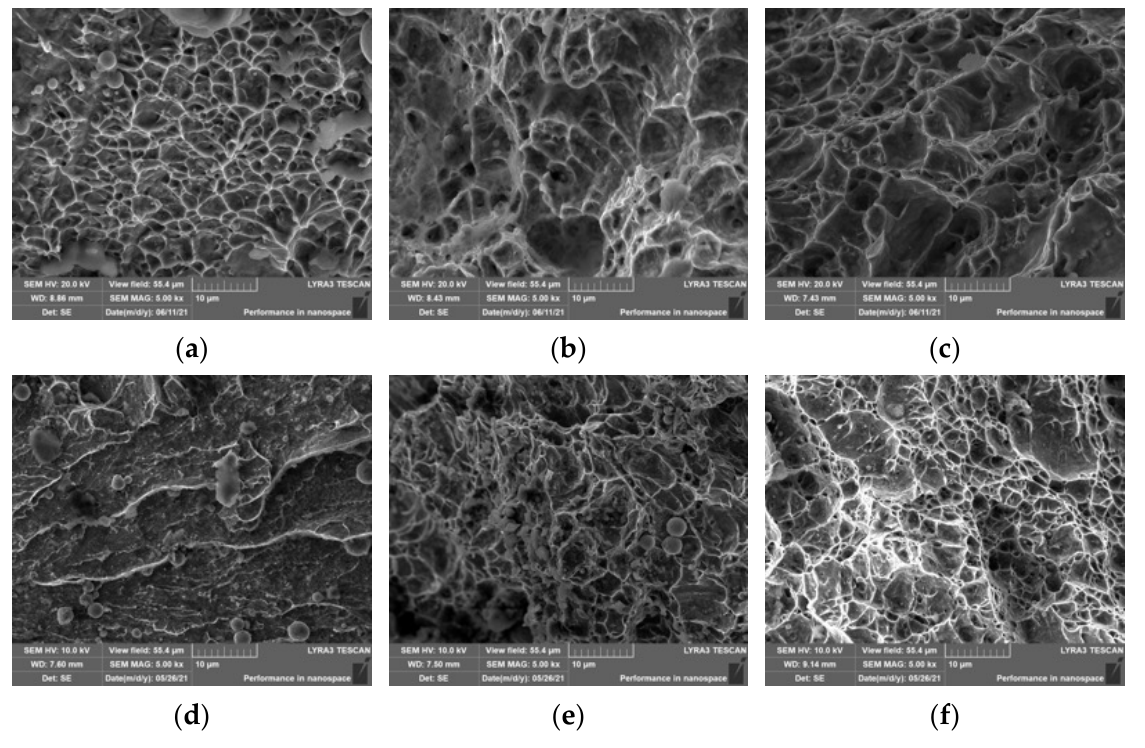
Figure 9. Morphology of the impact fracture of the welding thermal simulation samples: ( a ) CGHAZ of 0 V; ( b ) GRHAZ of 0 V; ( c ) ICHAZ of 0 V; ( d ) CGHAZ of 10 V; ( e ) GRHAZ of 10 V; and ( f ) ICHAZ of 10 V.